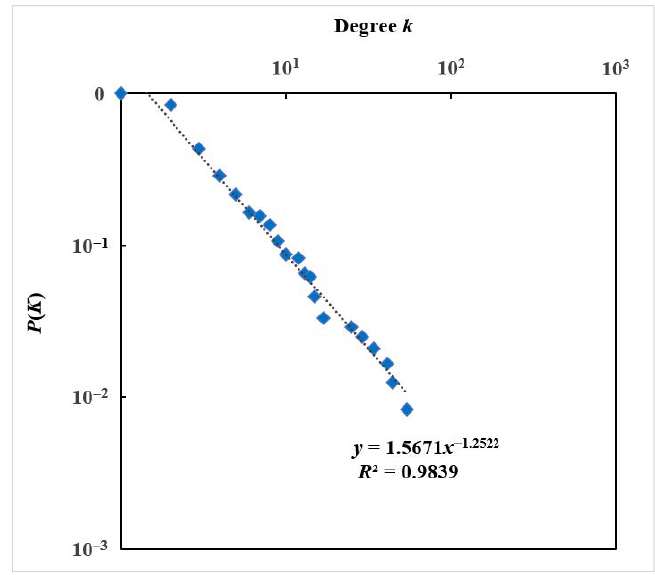
Figure 6. Cumulative degree distribution of HMTACN.